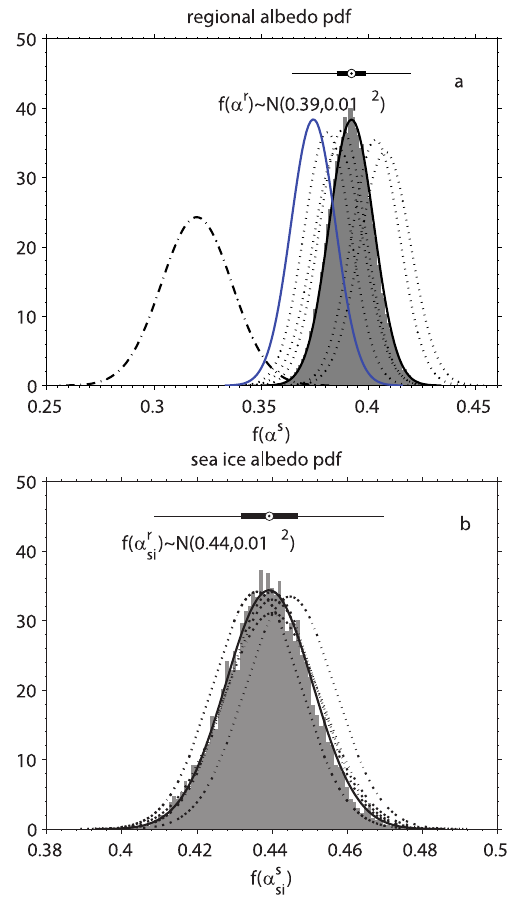
Figure 9. Regional (a) and sea-ice (b) bootstrap albedo pdfs ob- tained from merging the data from flights 1–5 (a) and 1–6 (b) . Solid black lines highlight the fitted Gaussian pdf with the parameters indicated in the panel. Dotted black lines show for the reference the fitted Gaussian pdfs for α s from flights 1–5 (a) and 1–6 (b) . Black dash-dotted and solid blue lines in (a) also show the boot- strap albedo pdfs for flight 6 and the regional albedo derived from merging the data from all 6 flights together, respectively. The box plots on the top of the panels use the same conventions as in Fig. 4.